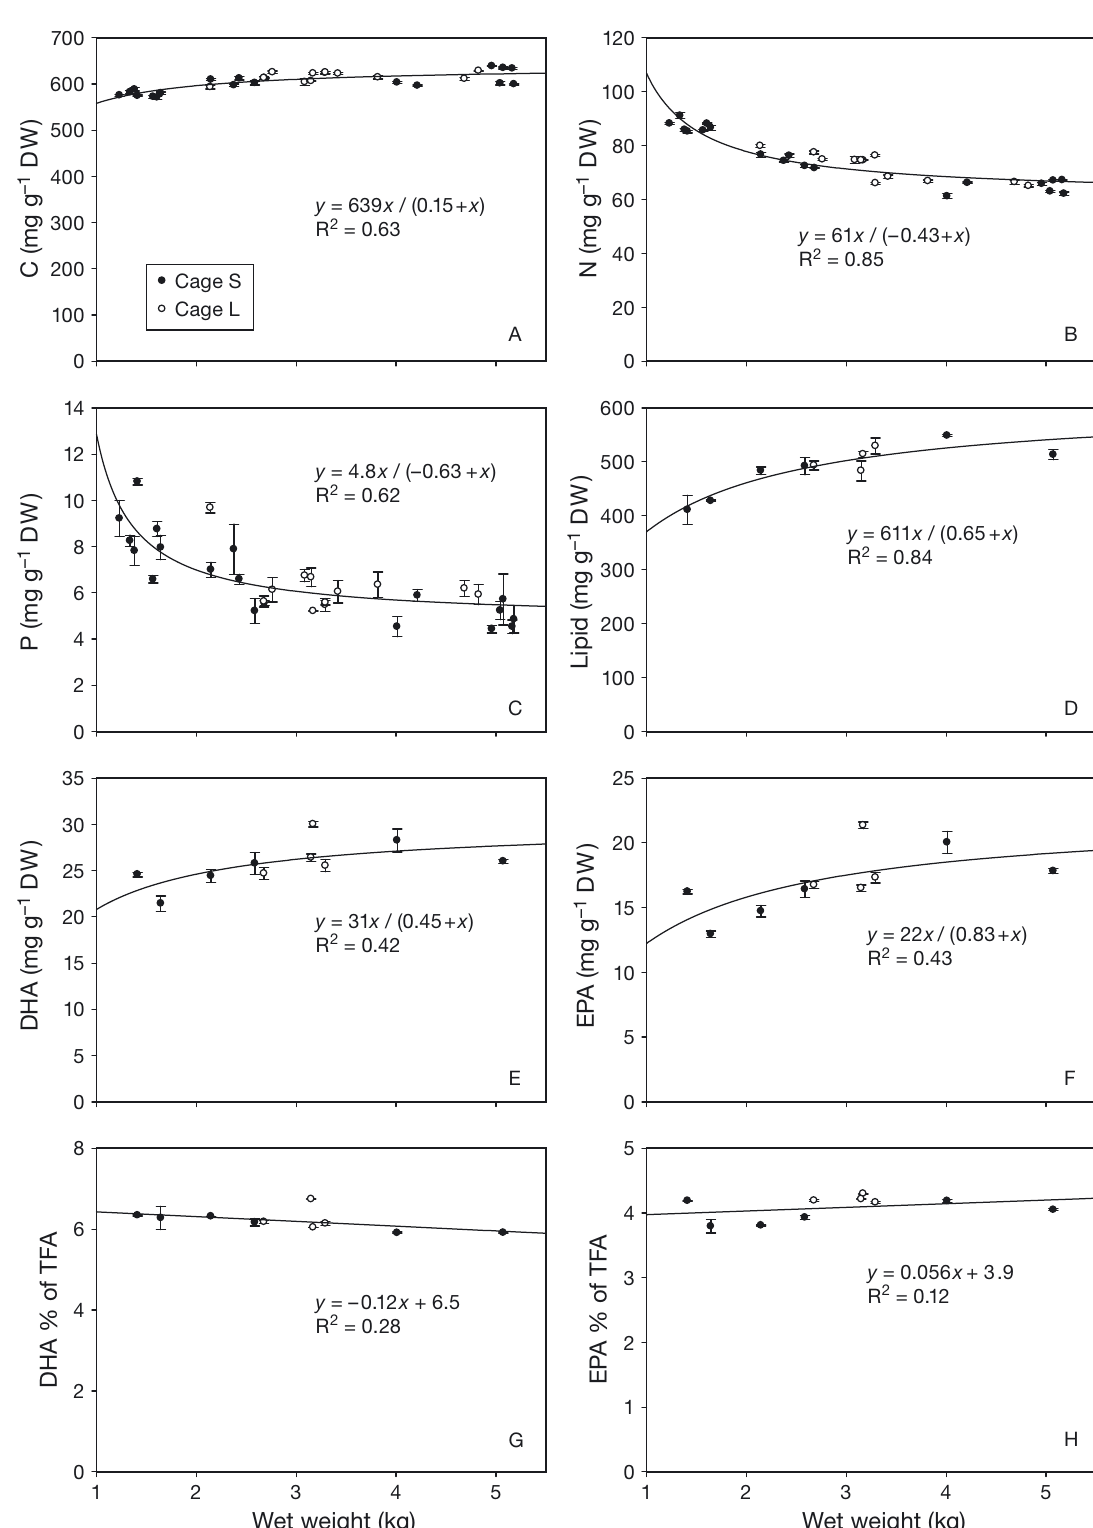
Fig. 6. Chemical contents per gram dry weight (DW) in fish whole-body samples from Cage S and Cage L in 2009 as a function of wet weight of individual fish. (A) Carbon; (B) nitrogen; (C) phosphorus; (D) lipid; (E) docosahexaenoic acid DHA; (F) eicosapentaenoic acid (EPA); (G) percentage of DHA in total fatty acid (TFA) content; and (H) percentage of EPA in TFA content. Error bars show ±1